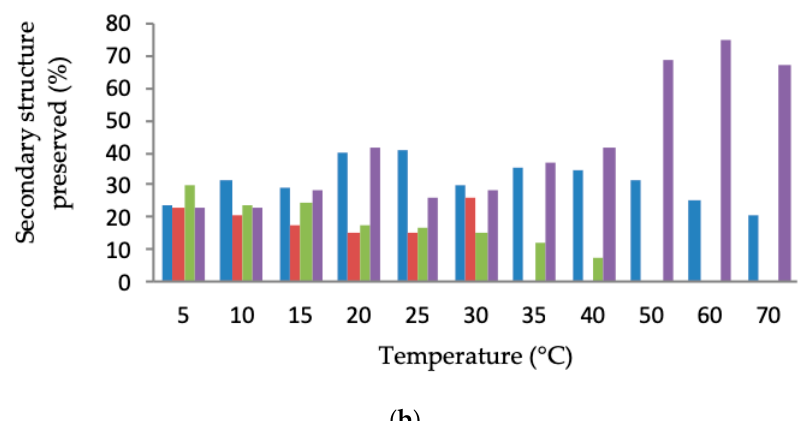
Figure 11. ( a ) LSK25 lipase melting point and secondary structure determination. Red vertical line indicates the melting point of LSK25 lipase when tested across a temperature ranging from 5–70 °C. Green line indicates the melting curve; blue line indicates the data background; circular dichroism milidegree (CD[mdeg]) vs. temperature. ( b ) Changes in the secondary structure of LSK25 lipase at different temperatures. Indicator: helix (blue), β -sheet (red), turn (green), random coil (purple).